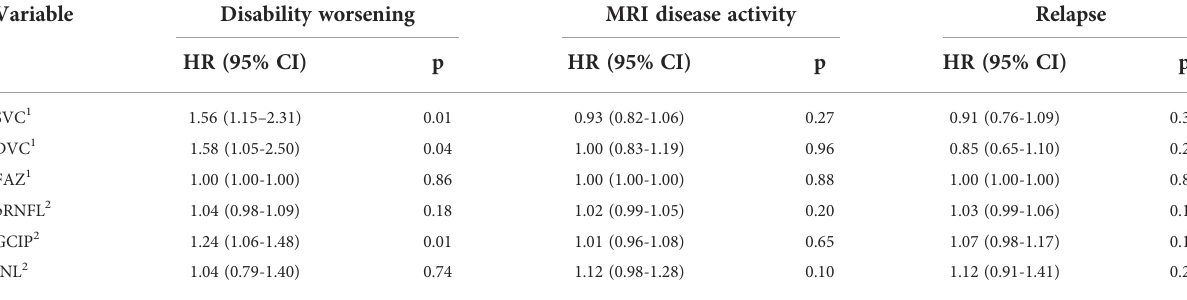
Cox proportional hazard models for optical coherence tomography angiography (OCT-A) predictors on disability worsening, MRI disease activity and occurrence of relapse adjusted for age,sex,diseasedurationanddiseasemodifyingtherapy.(1)Decreaseof1%pointinvesseldensity;(2)decreaseof1μminlayerthickness.Hazardratio(HR)with95%con fi denceintervals (CI); super fi cial vascular complex (SVC), deep vascular complex (DVC) and foveal avascular zone (FAZ) as measured by OCT-A; peripapillary retinal nerve fi ber layer (pRNFL), common ganglion cell layer (GCIP) and inner nuclear layer (INL) as measured by optical coherence